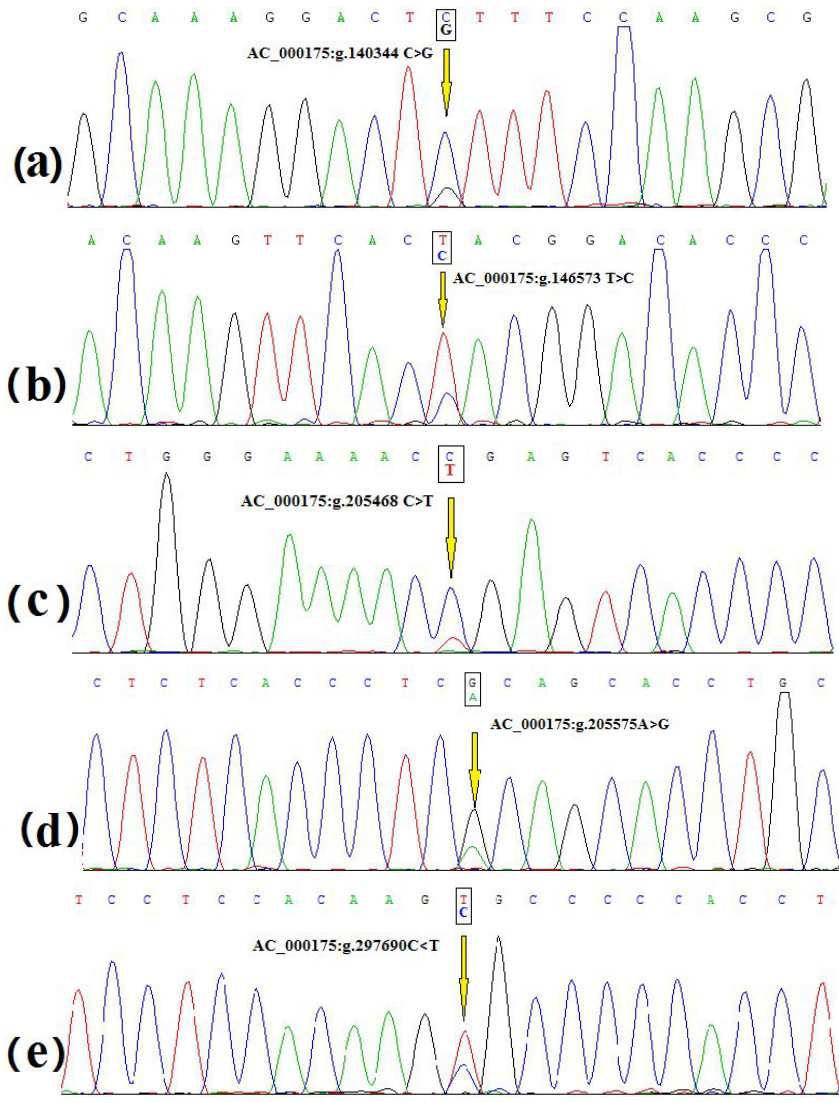
Figure 1. Sequence chromas of five novel SNP loci in the bovine ATBF1 gene. Note: panels (a) , (b) , (c) , (d) and (e) represent the pooling sequence chromas of SNP1, SNP2, SNP3, SNP4 and SNP5,